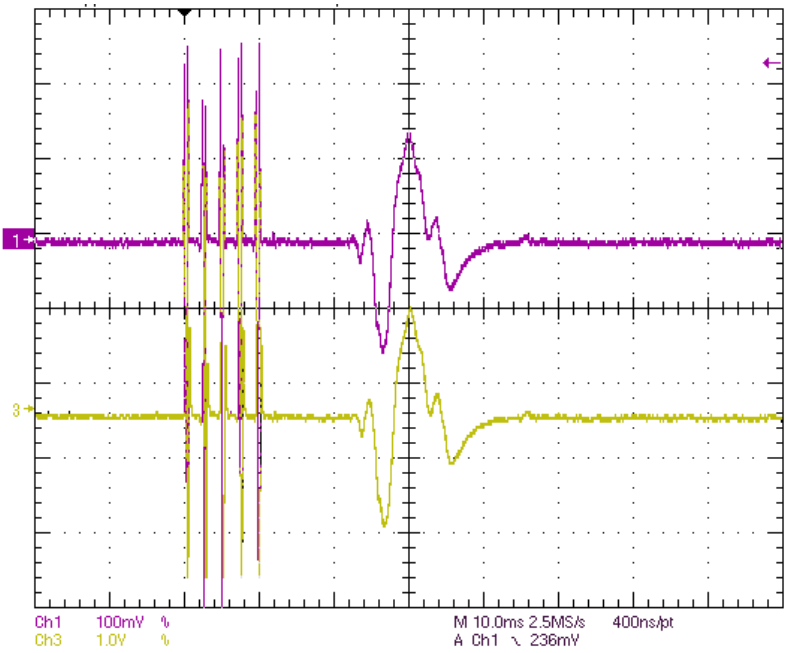
Figure 9. Amplification and ADC stage in Transmitter. Purple track: input signal; Yellowish track: embedded DAC output signal. Horizontal scale is